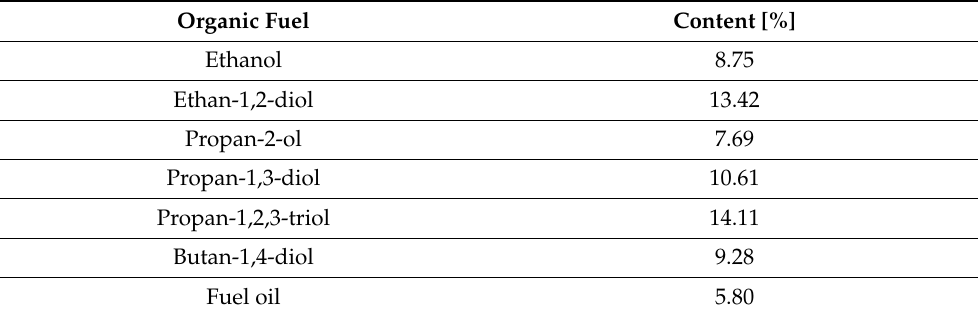
Table 2. Fuel content in explosives with AN with zero oxygen